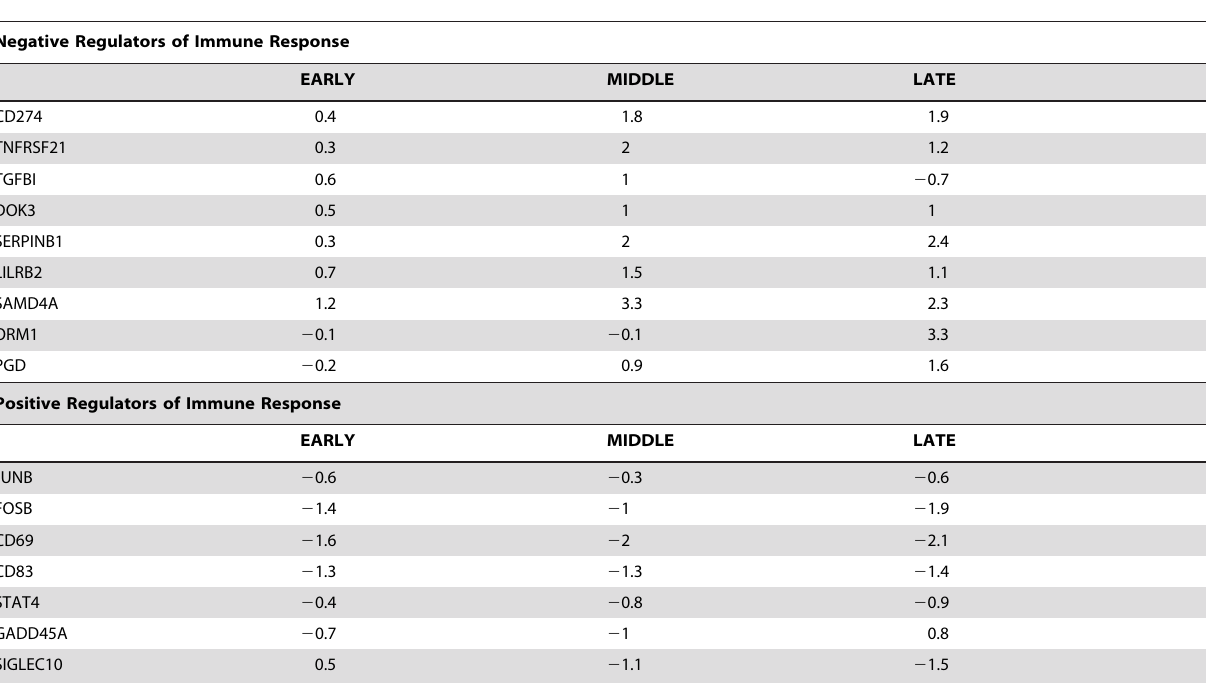
Table showing the log2 fold change (from pre-exposure control) in the expression of the negative or positive regulators of immune-response genes at early, middle, and late induced times post-LASV infection of NHPs.